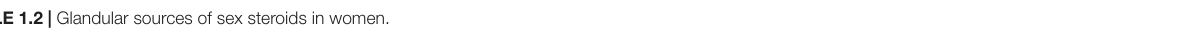
TABLE 1.2 | Glandular sources of sex steroids in women. Adrenal gland